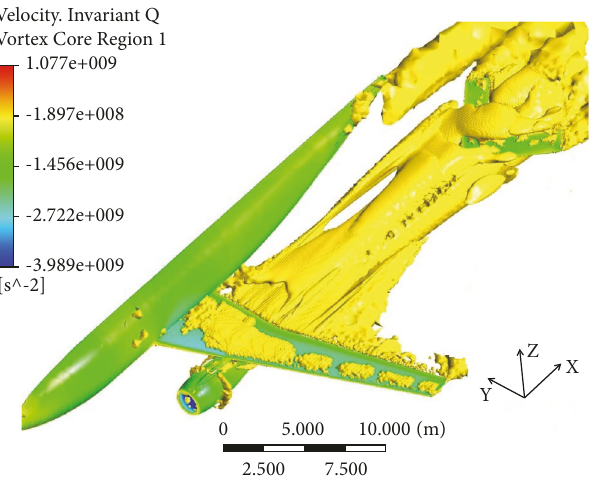
Figure 12: Influence of the jet flow on the fly wing.